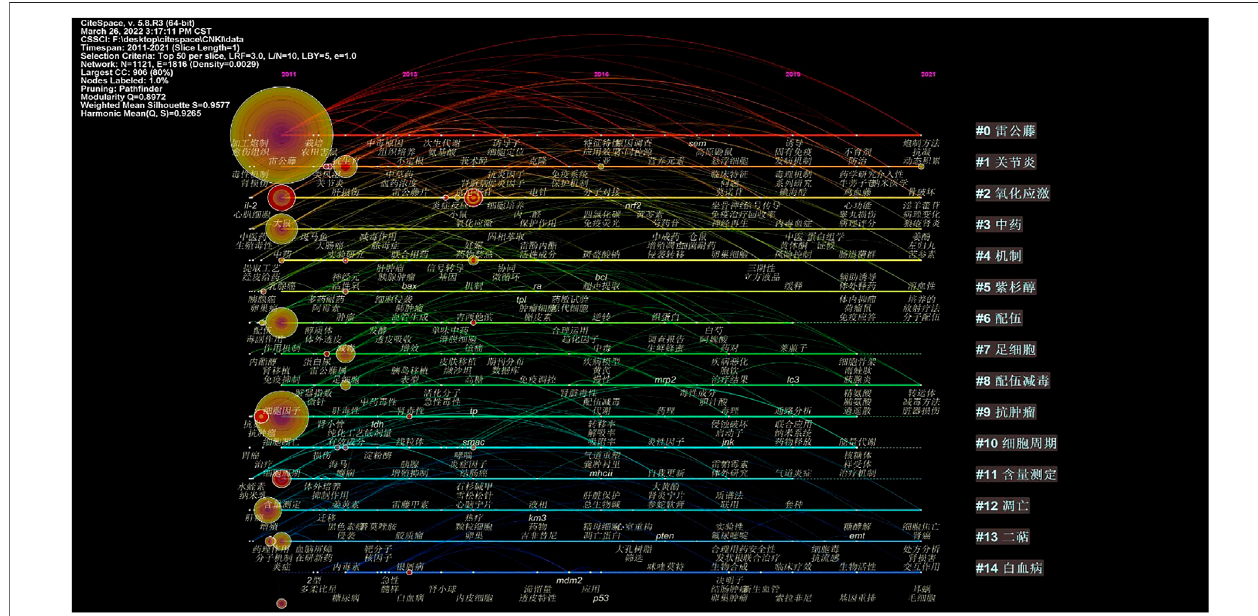
FIGURE 10 | Timeline of the cluster network of keywords from the CNKI.